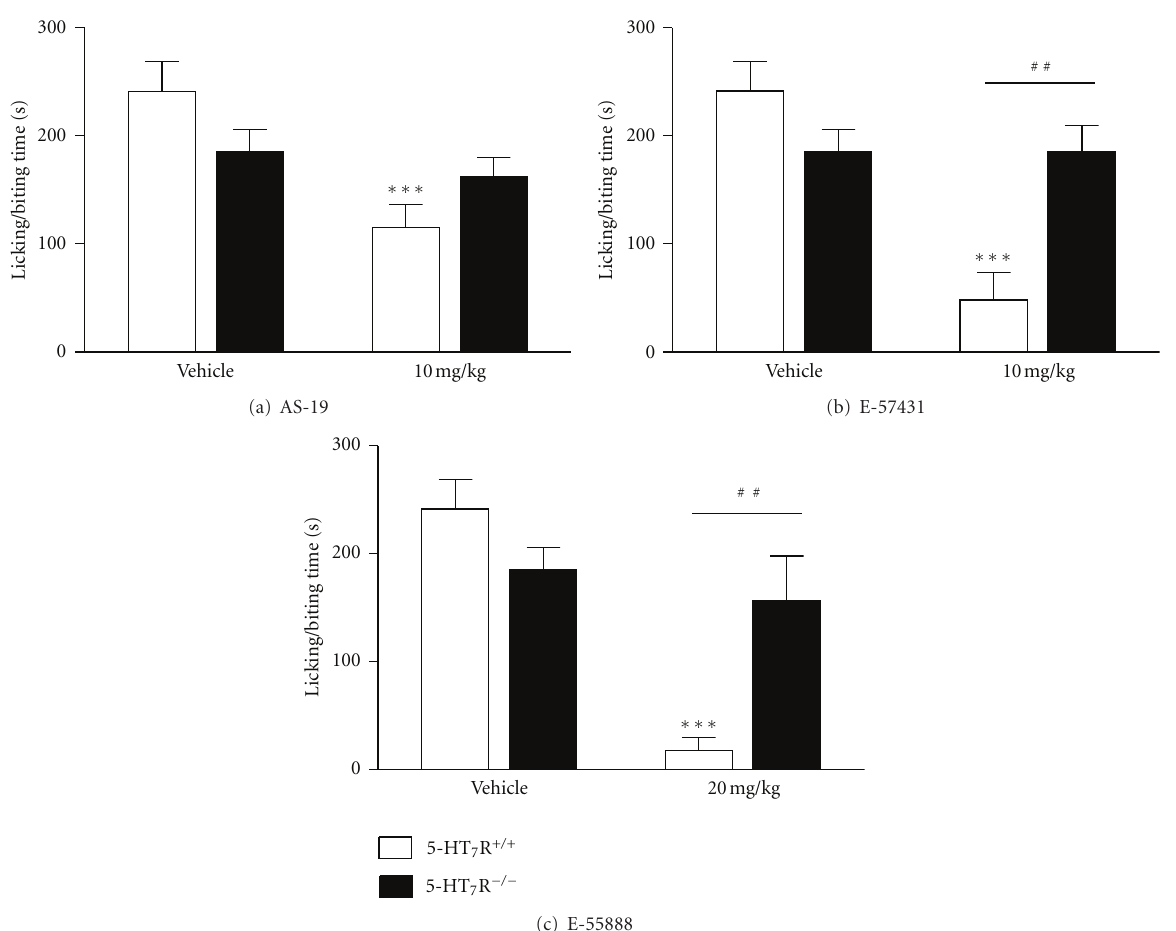
Figure 2: E ff ects of 5-HT 7 receptor agonists AS-19 (a), E-57431 (b), and E-55888 (c) on formalin-induced nociceptive behaviors during phase II in wild-type and 5-HT 7 receptor knockout mice. Subcutaneous administration of AS-19 (10mg/kg), E-57431 (10mg/kg), and E- 55888 (20mg/kg) significantly reduced the licking/biting time of the hind paw injected with formalin in wild-type but not in 5-HT 7 receptor knockout mice. Each bar represents the mean ± S.E.M. ( n = 7–12). ∗∗∗ P < 0 . 001 versus vehicle corresponding group; ## P < 0 . 01 versus corresponding dose in 5-HT 7 receptor knockout mice (Bonferroni multiple comparison test after